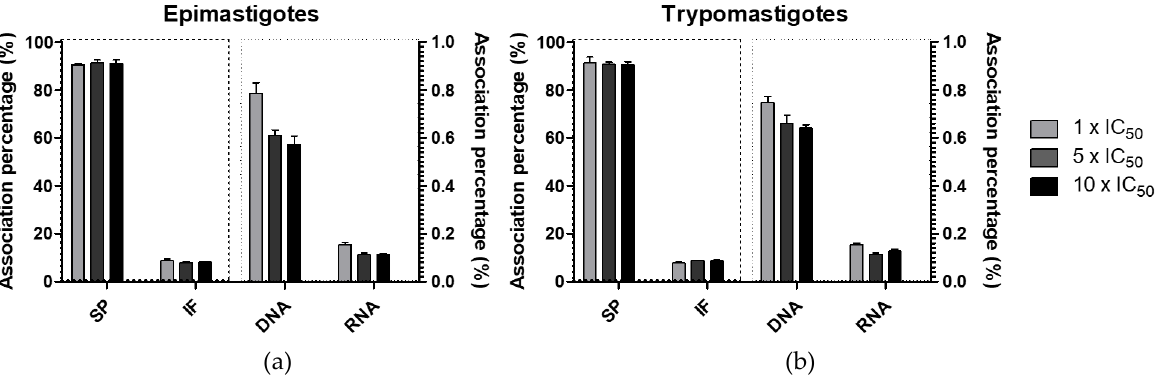
Figure 6. Percentage of vanadium associated with the different isolated macromolecules of ( a ) epimastigotes; ( b ) trypomastigotes, after 24 h of treatment with 1 × , 5 × and 10 × the calculated IC 50 value of [V V O(IN-2H)(L2-H)] on trypomastigotes of T. cruzi . The average and SD of independent triplicates of determinations in DNA, RNA, soluble (SP) and insoluble fraction (IF) are shown.